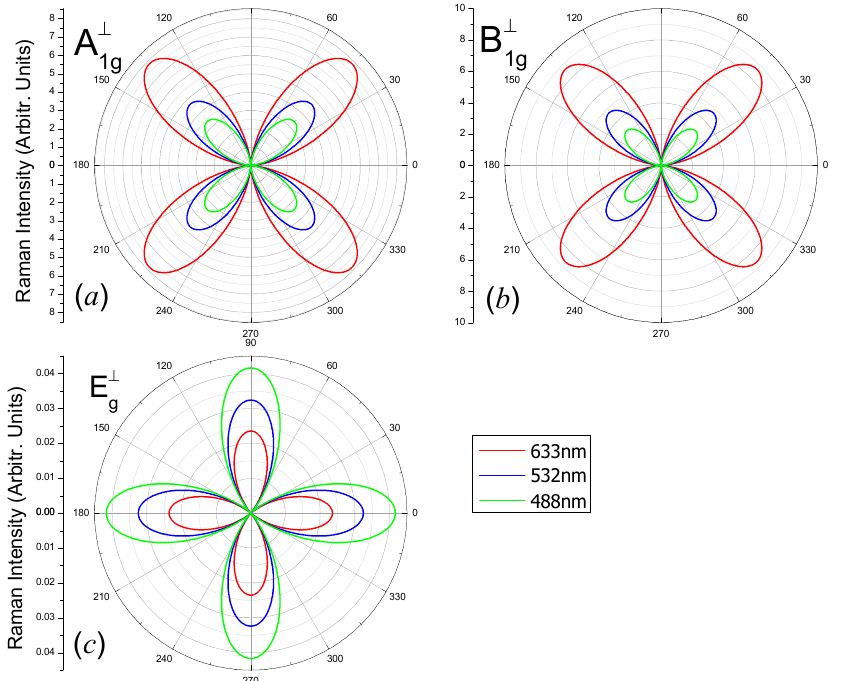
(cid:2870) ↔ 2 of ( a ) A 1g ‐ 1734 (cid:42) (cid:42) e s · R · e i | of ( a ) A 1g -1734 cm − 1 ,